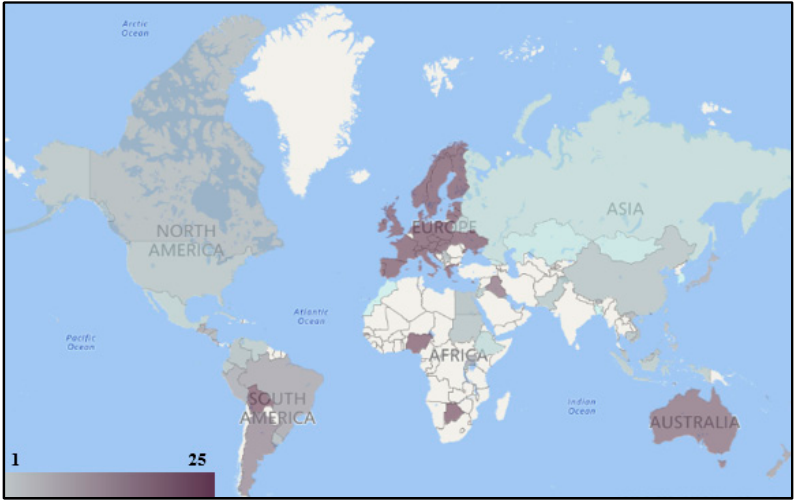
Figure 3. Geographic distribution of the nations regulating the 25 selected pesticides in drinking water.